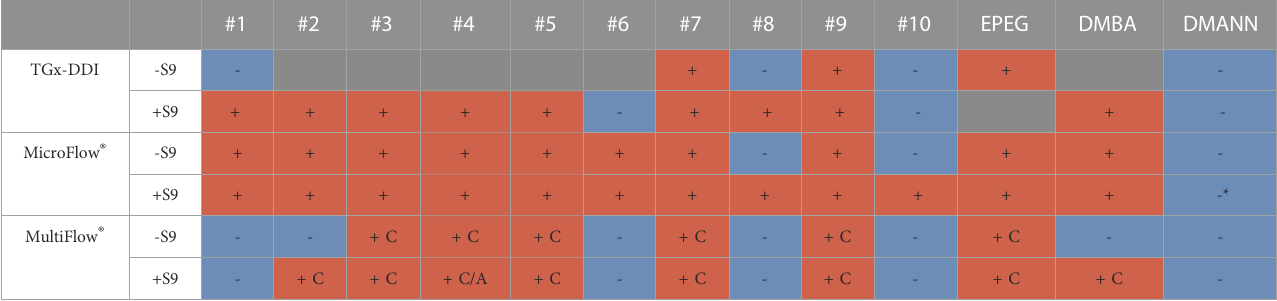
(Supplementary Figure S5). Positive controls, EPEG and